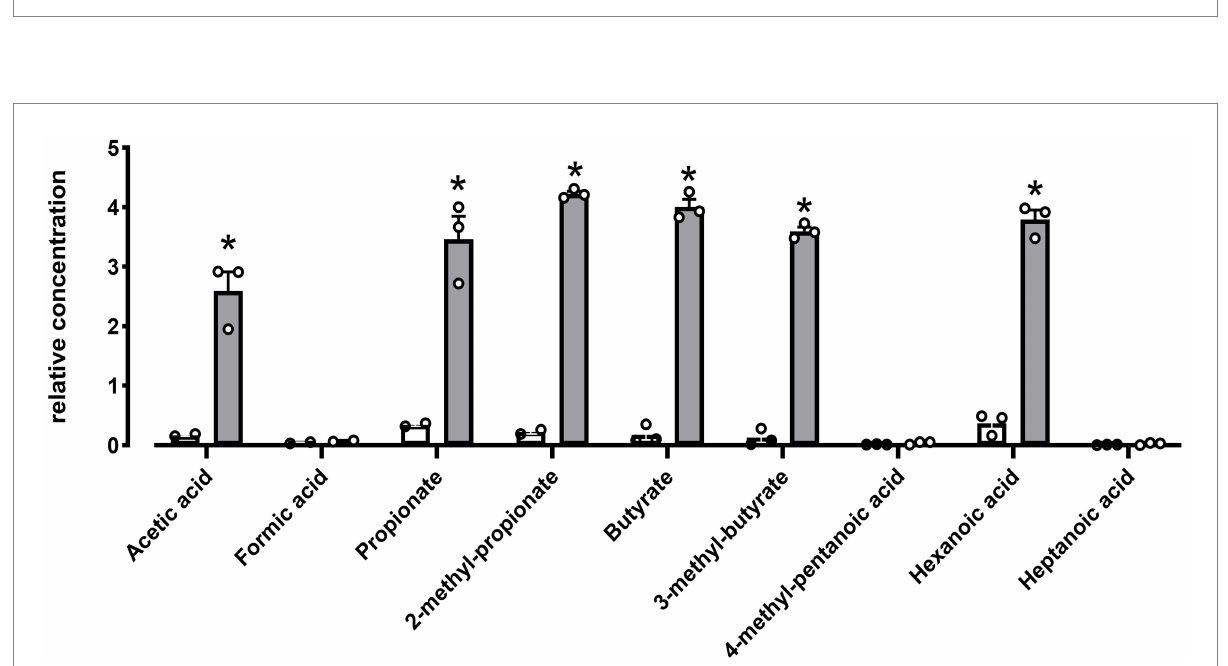
FIGURE 5 DE111 ® increased free amino acid concentrations in UHT fermented milk samples. Statistical analysis performed using Multiple T test – using unpaired parametric, Two-stage step-up (Benjamini, Krieger, and Yekutieli) and * p -value ≤ 0.01. The graph presents average activities ( n = 3 ± SEM). The white bar represents the control and gray bar represent DE111 ® .